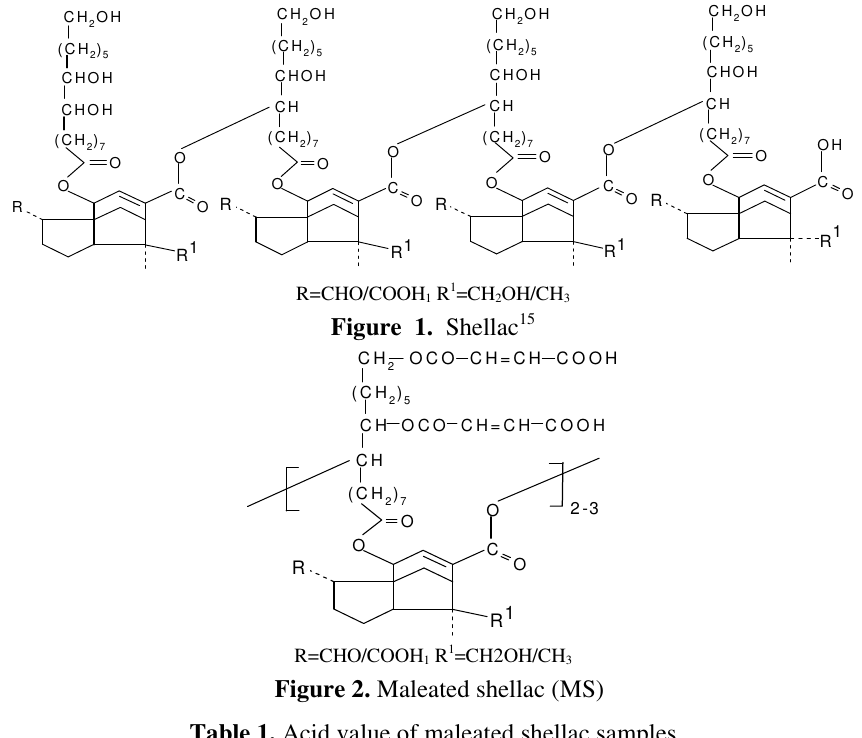
Figure 1. Shellac 15